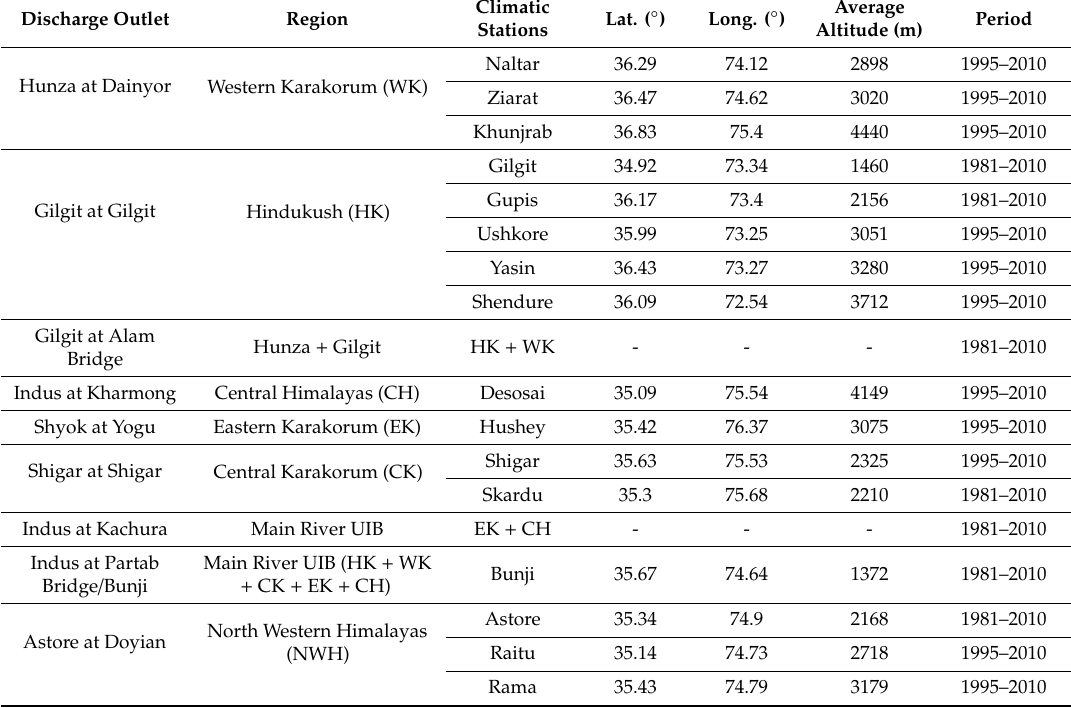
Table 3. Characteristics of climatic gauging stations in the Upper Indus Basin